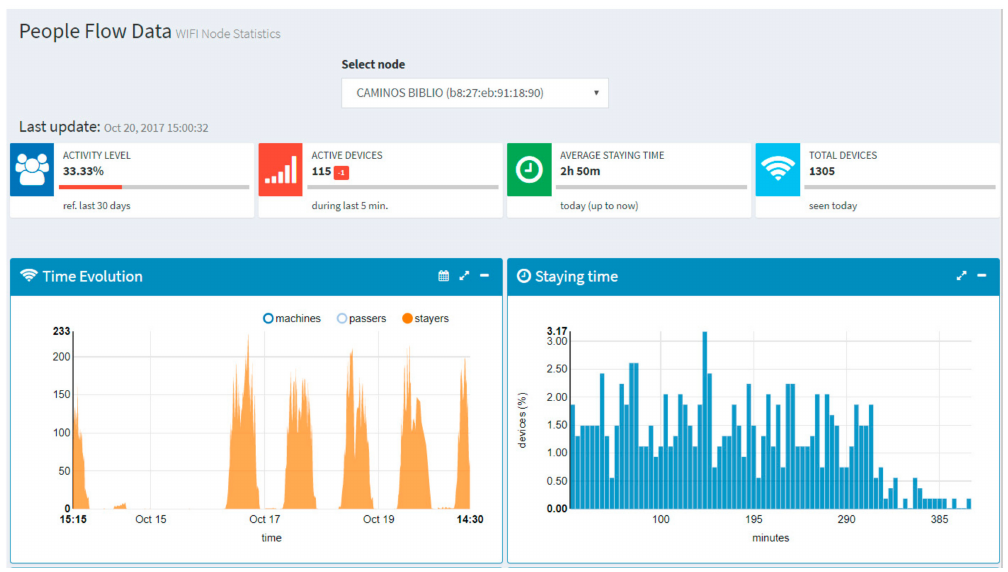
Figure 11. View associated to the people flow monitoring sensor installed in the library of the Civil Engineering